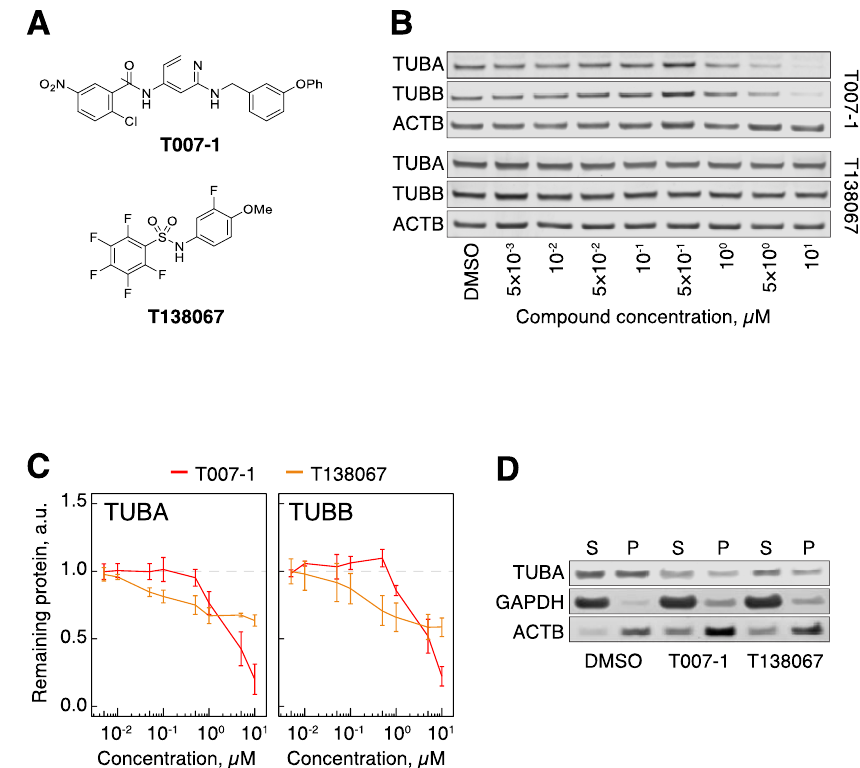
Figure 2. Covalent binders target tubulin for degradation. ( A ) Structural formulae of T007-1 and T138067. ( B ) TUBA and TUBB protein levels in hTert-RPE1 cells upon treatment with T007-1 and T138067. ( C ) Quantification of tubulin protein levels across the indicated conditions. All data are normalized to reference protein (ACTB) and tubulin protein levels in DMSO-treated cells. Lines represent the average of three biological replicates. Error bars represent standard error of the mean (SEM). ( D ) Biochemical partitioning of tubulin into soluble (S) and polymerized (P) forms across the indicated conditions. Note that both the S and the P fraction of tubulin decrease upon treatment with 1 μ M T007-1 and T138067 for 5 h.